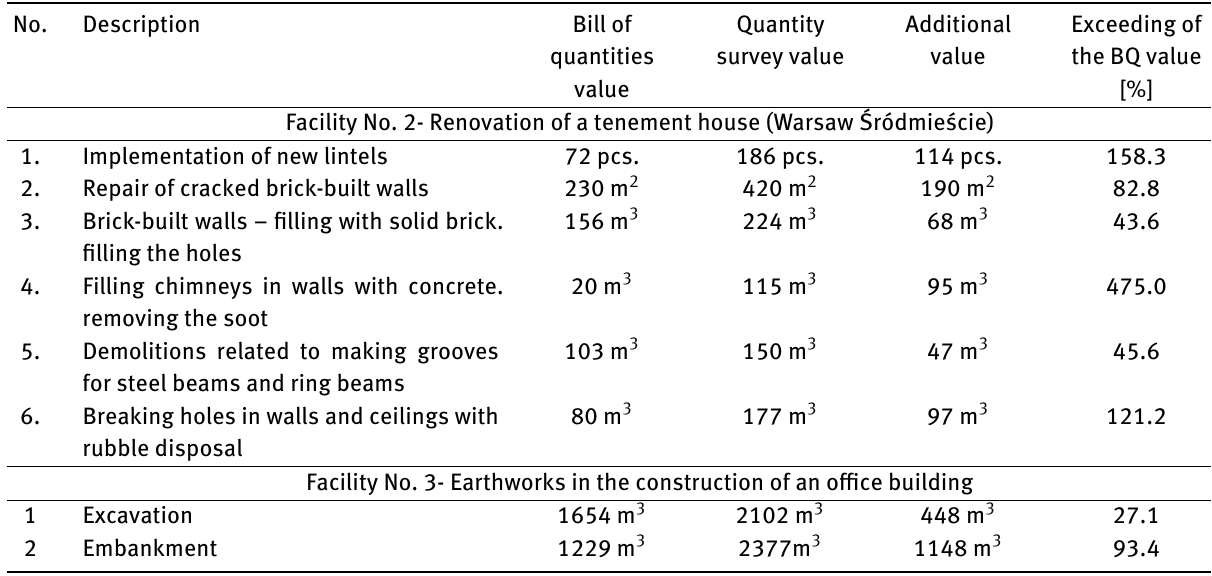
Table 5: Comparison of values of bill of quantities and quantity survey of selected works in facilities 2 and 3